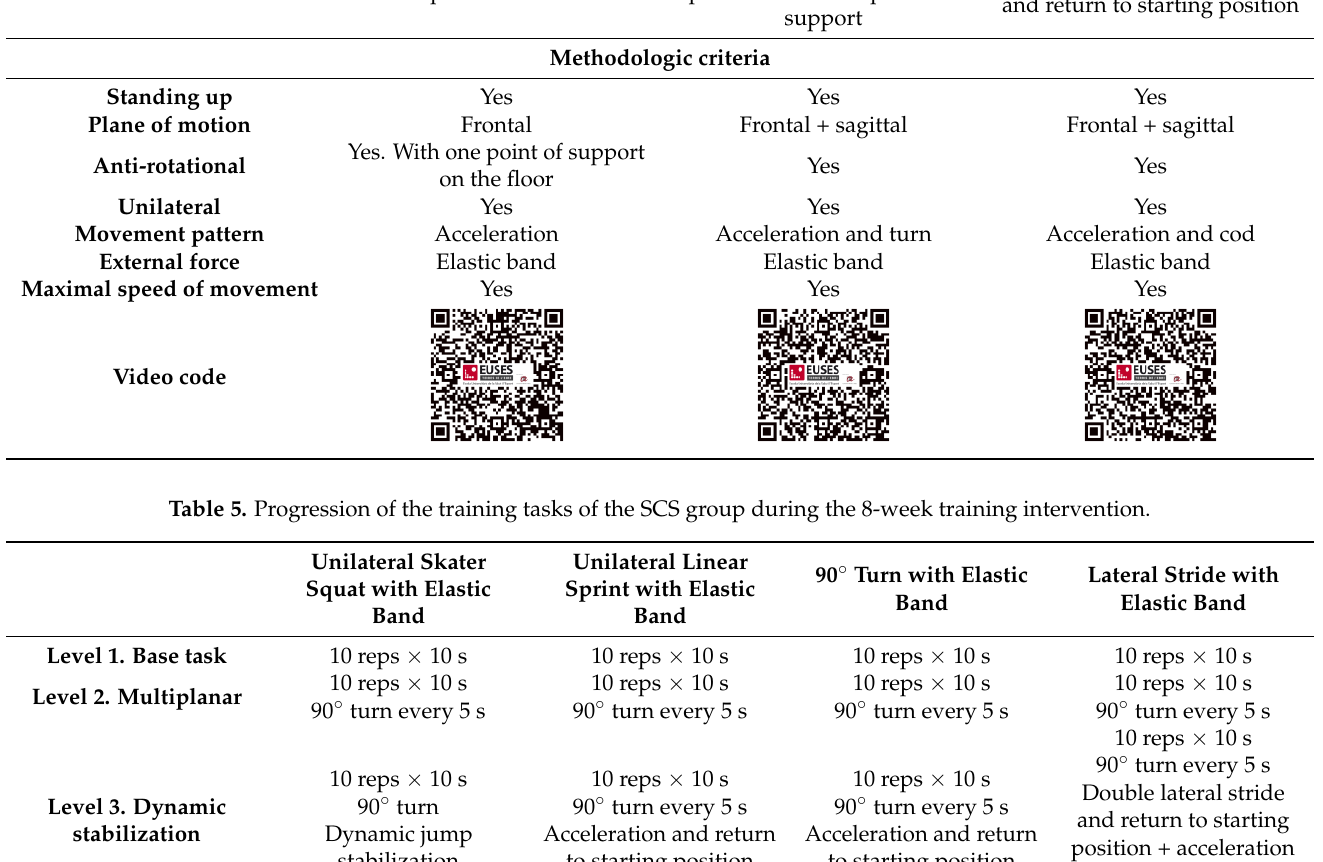
5”: explosive action and stability holding final position + 5”: repeat the same action 5”: explosive action and stability holding final position + 5”: 90° turn and stability holding final position elevating the free leg 5”: explosive action, acceleration, and return to starting position + 5”: 90° turn with acceleration and return to starting position Methodologic criteria